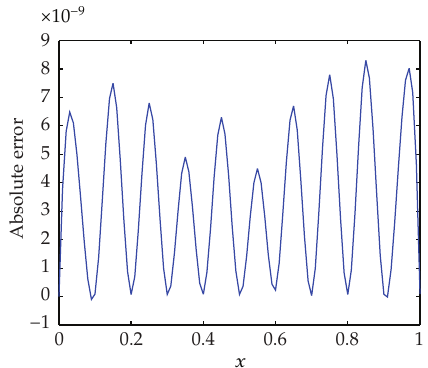
Figure 2: Absolute error of Example 6.3 for N (cid:8) 10, M (cid:8) 3.